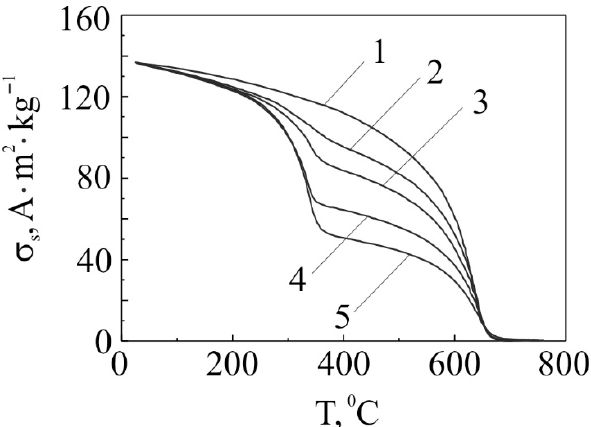
Figure 7. Temperature dependences of the specific saturation magnetization of AISI 420 steel after laser alloying with a plaster of 15Fe + 30Ni + 20B + 10Si + 25% liquid glass for various heating/cooling modes: 1—heating rate (V h ) 30 °C/min, 2—cooling rate (V c ) 30 °C/min, 3—V c = 60 °C/min, 4—V c = 80 °C/min, 5—V c = 100 °C/min.